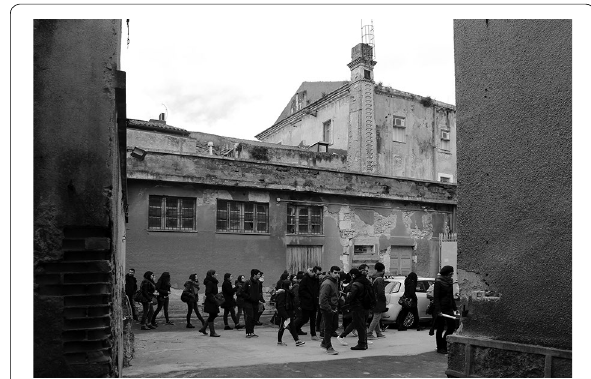
Fig. 1 Site visit to the project areas. Internal space of the former Jesuit College, headquarters of the University of Sassari, Sassari. Photo: R.